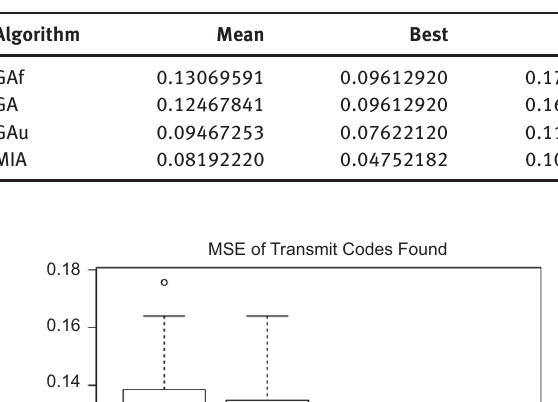
Table 11. Length 49 64 PSK